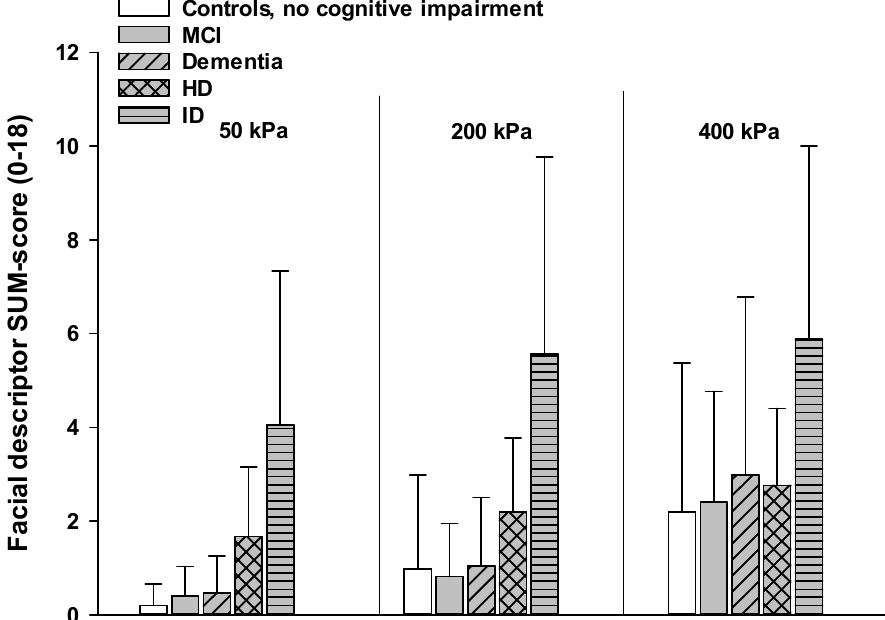
Figure 3. Step 3, encoding—comparison between types of cognitive impairment: Comparing mean SUM-scores (SD) of individuals with different types of cognitive impairments.